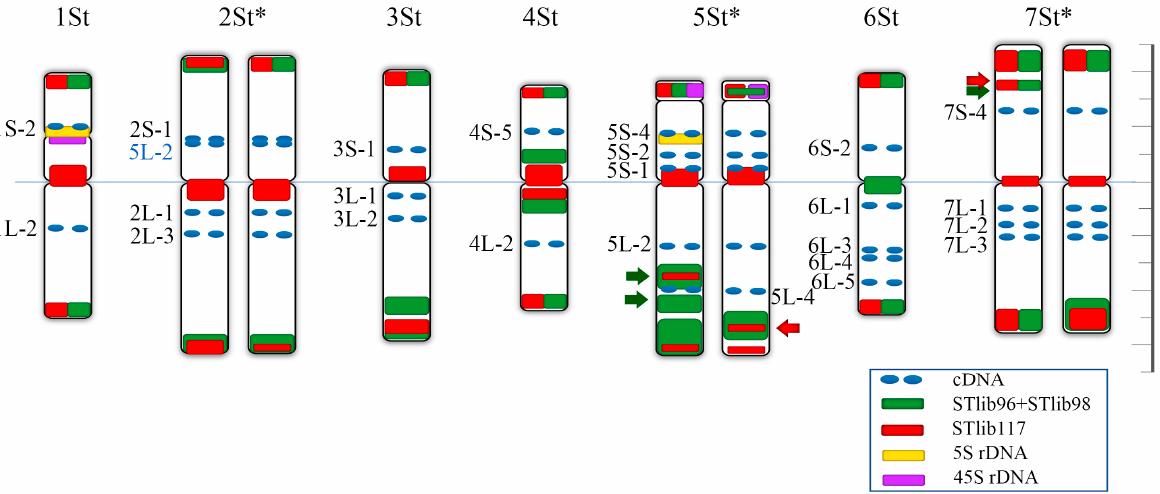
Figure 5. Idiogram of P. libnotica . Asterisks on 2St, 5St, and 7St indicate heterozygous between homologous chromosomes. Green and red arrows present repeat duplication compared with homologous chromosomes. The name of cDNA probes that hybridized to a non-homoeologous chromosome is highlighted in blue. The color scheme (bottom right) shows the color of each probe as represented in this idiogram. The scale on the right side consists of 2 units, and each unit represents 0.5 μ m.